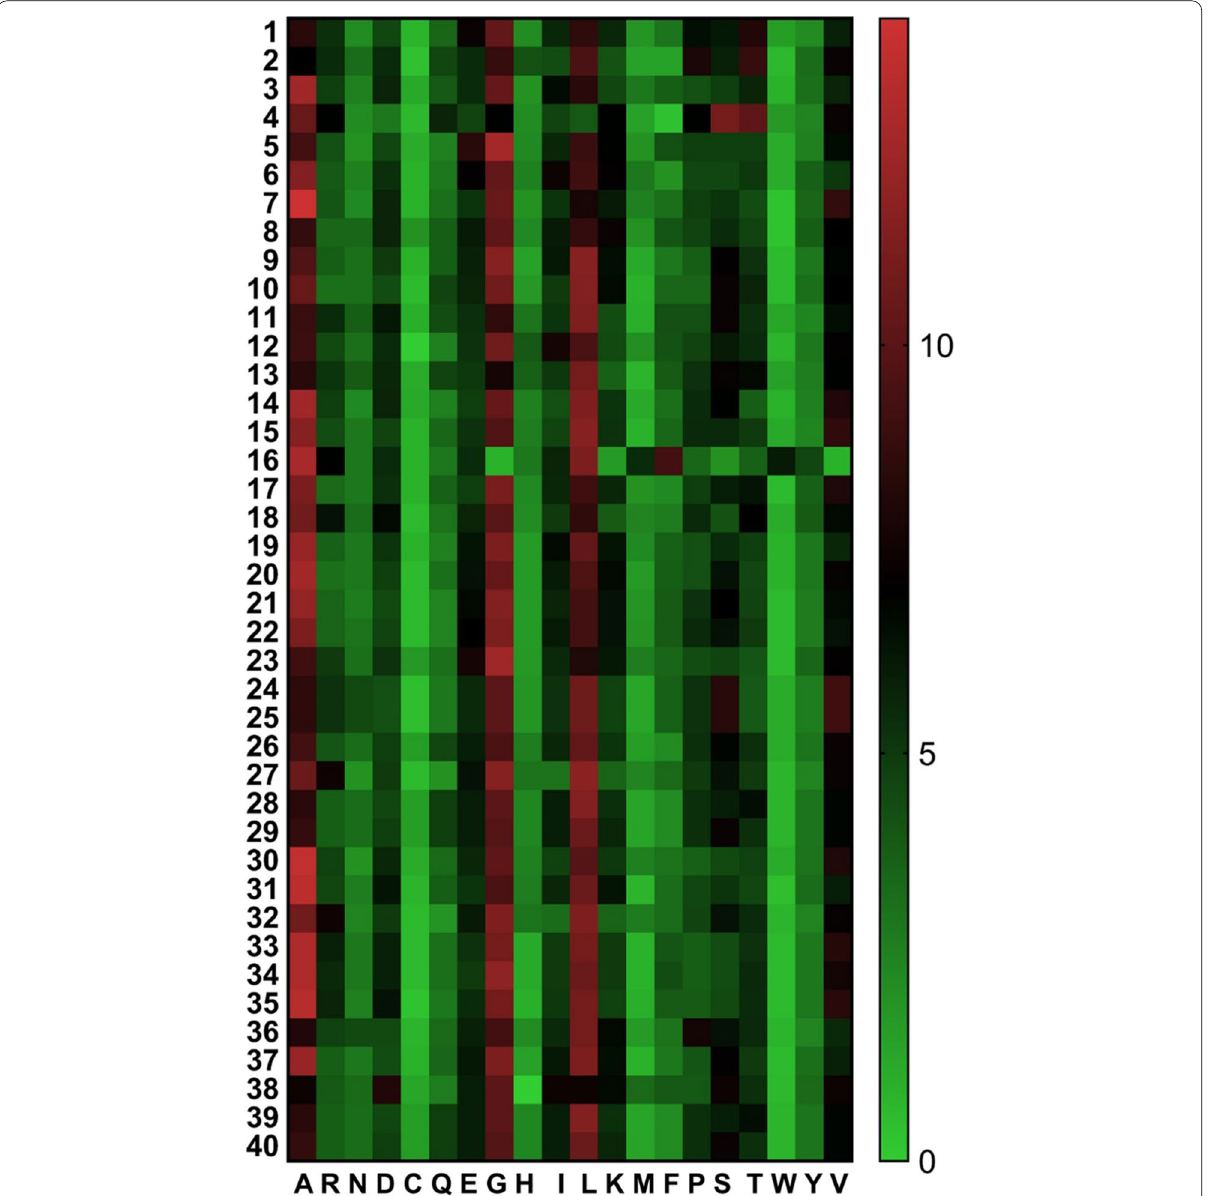
Fig. 2 Heatmap analysis depicting variation in amino acid composition among 40 fungal ACC deaminases (ACCNK1 to ACCNK40 are denoted as 1–40 respectively). Amino acids are given in one-letter code. The scale in the right side of heatmap represents percentage of amino